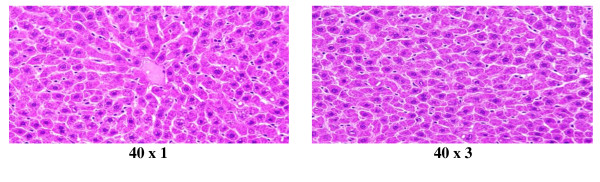
GNPs-normal rat